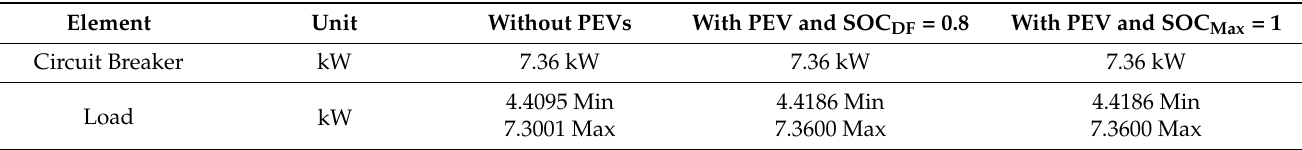
Table 1. Power demand and loss, current and voltage at home (flat rate). Element Unit With PEV and SOC DF =